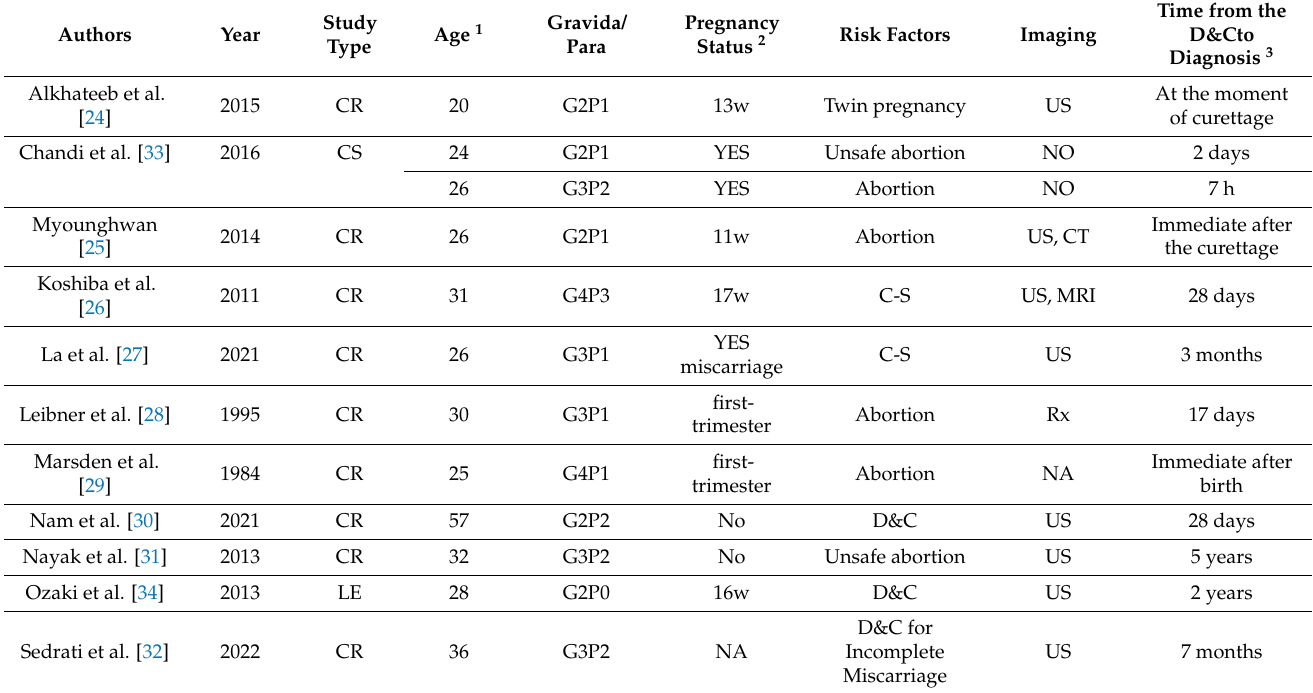
Table 1. Characteristics of the included